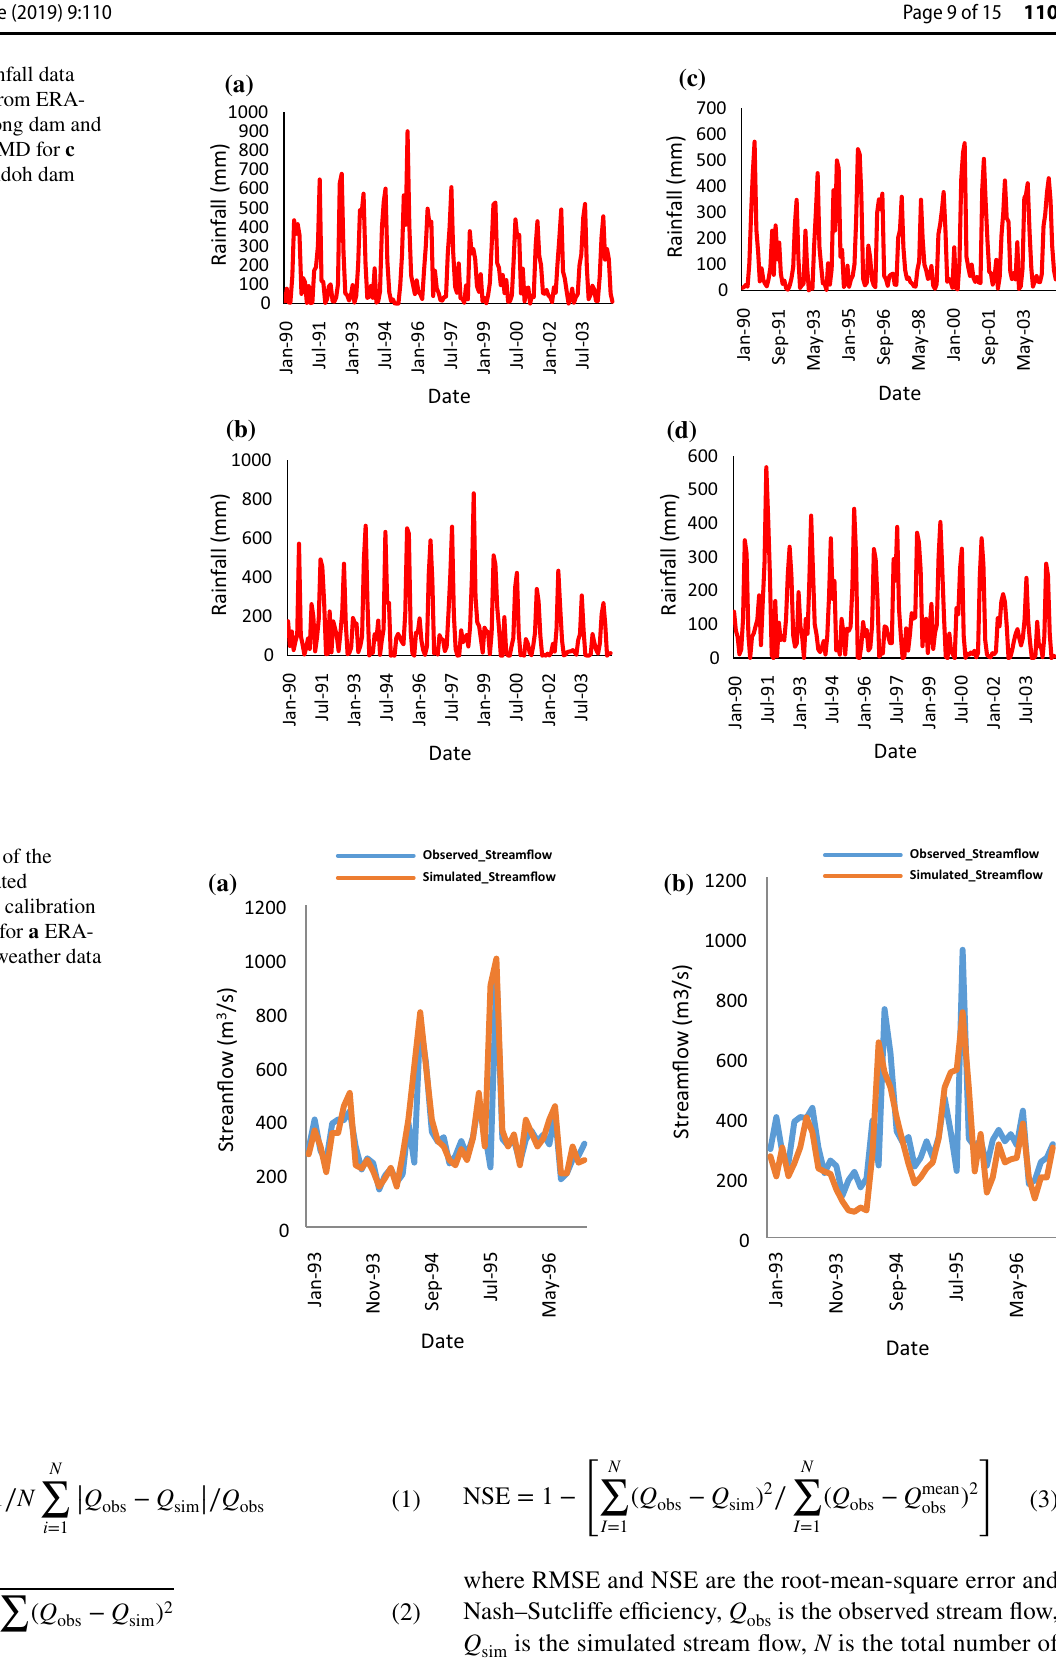
Fig. 11 Hydrograph of the observed and calibrated monthly flow for the calibration period of Pong dam for a ERA- Interim and b IMD weather